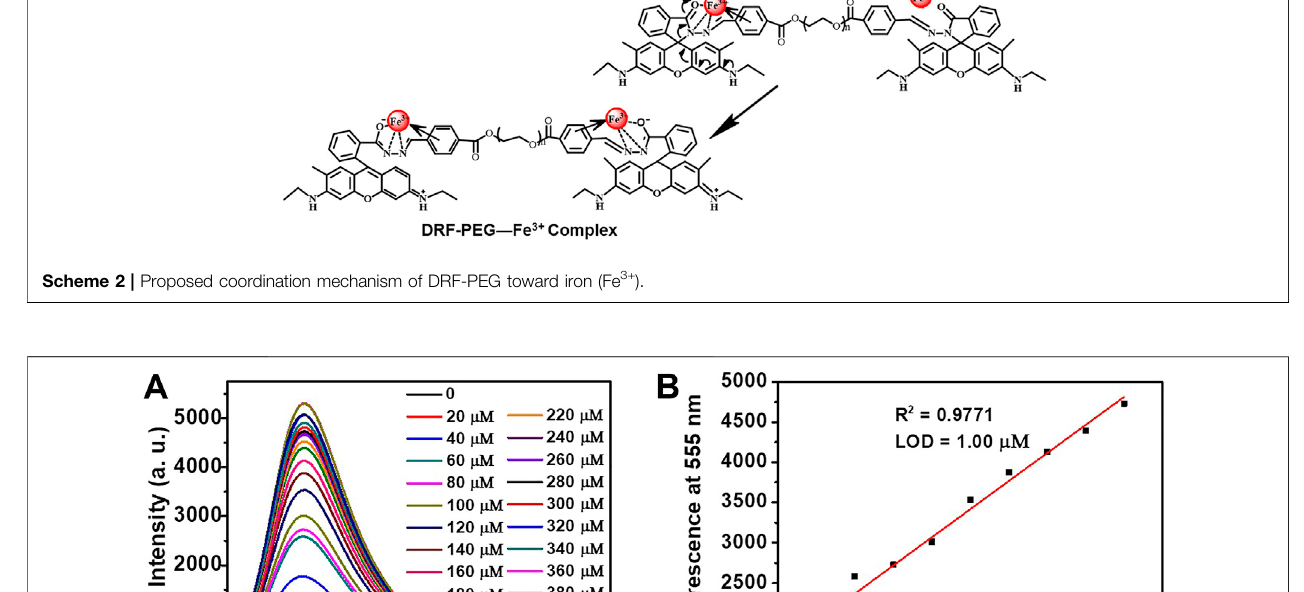
Frontiers in Chemistry |